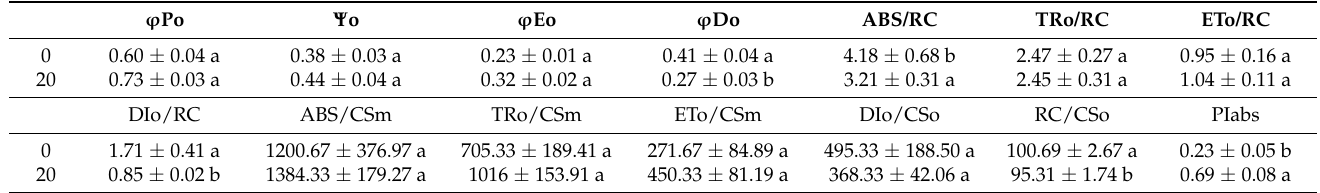
Table 2. Effects of ALA on PSII energy distribution and specific activity parameters of P. heterophylla at late growth stage.